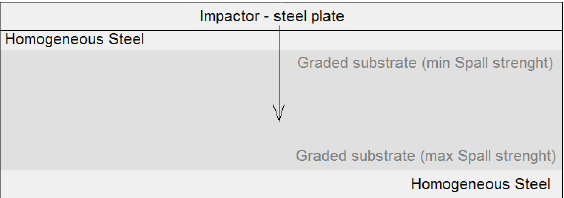
Fig. 4. FGM-sample before impact. Gray shade allocated gradient substrate in the sample. Gray color is allocated homogeneous steel. The velocity vector is directed downward.